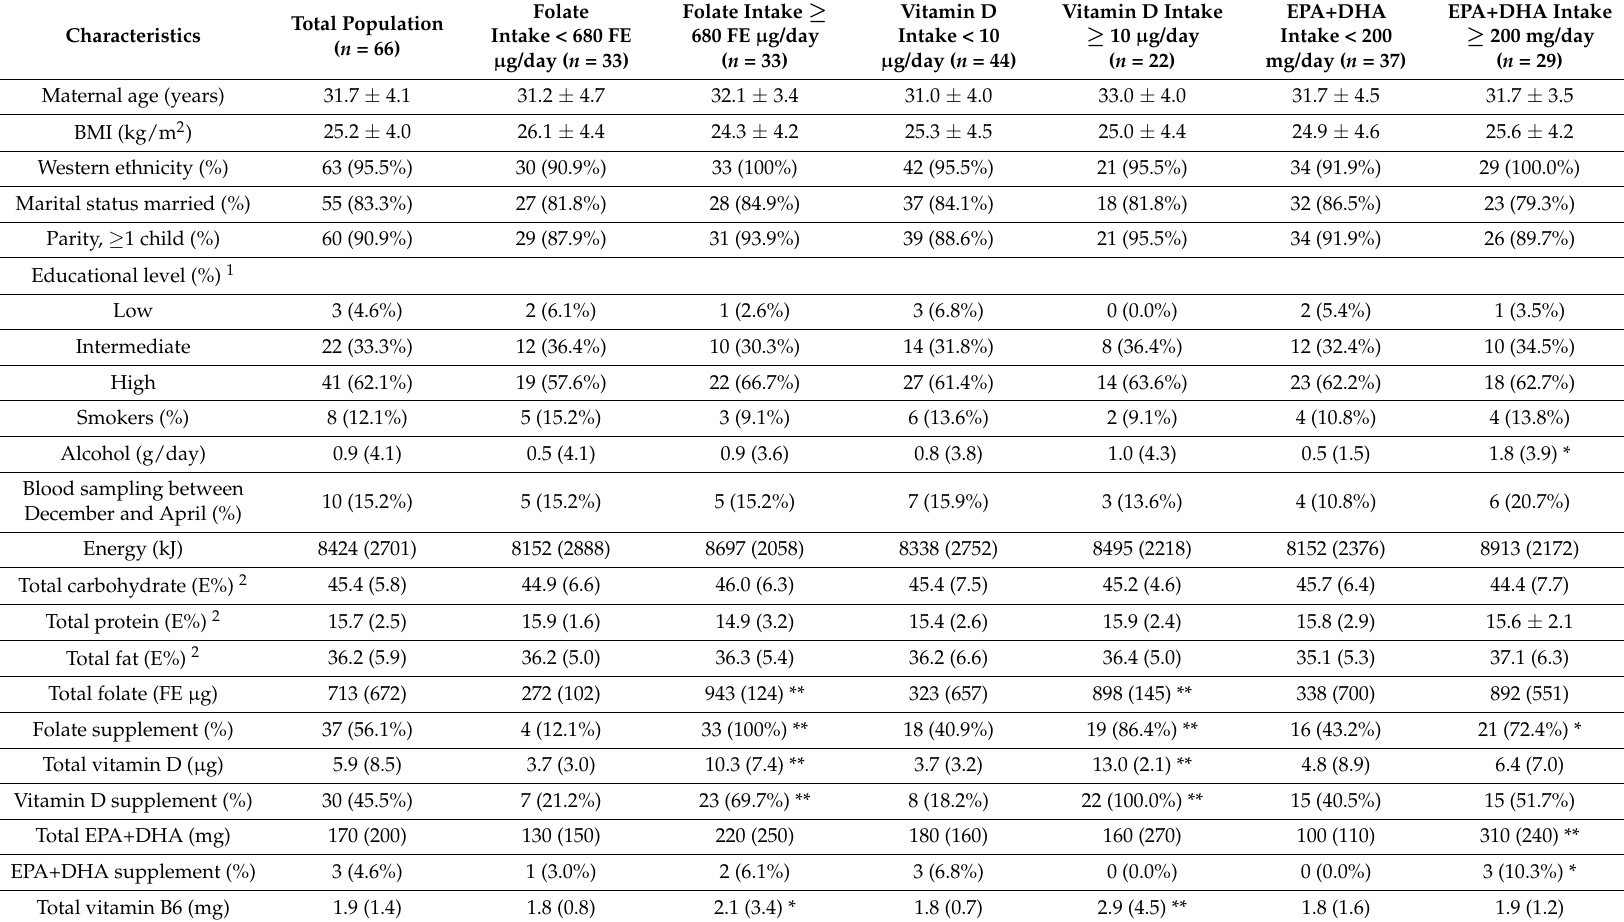
Table 1. Characteristics of the total study population ( n = 66) and stratified by meeting the recommended intake of folate, vitamin D, and EPA+DHA for women in the preconception period according to the Health Council of the